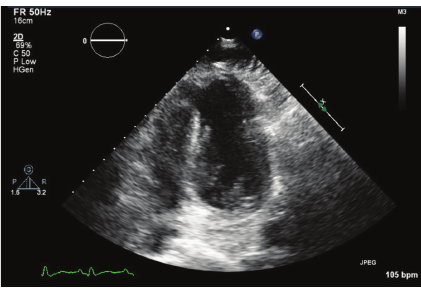
Figure 2: Transthoracic echocardiogram demonstrating ventricular septal defect.